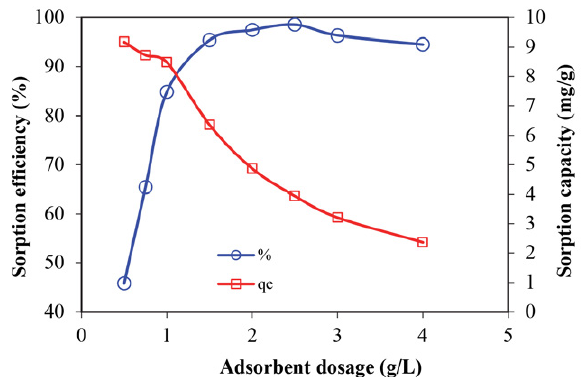
Figure 9. Impact of MnFe 2 O 4 dose on sorption efficiency and sorp- tion capacity of P ions (Conditions: pH = 6, mixing rate = 500 rpm, P ion concentration = 10 ppm, contact time = 60 min, and temper- ature = 55 °C)